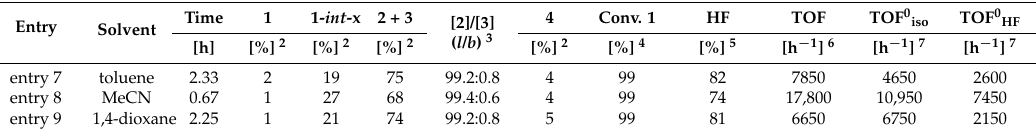
Figure 5. Influence of the solvent on the amount of internal isomers ( 1- int -x ) as a function of time in tandem isomerization-hydroformylation of 10-undecenitrile at [ 1 ] 0 /[Rh] = 3000 ( (cid:7) 1,4-dioxane, (cid:4) acetonitrile, (cid:78) toluene). Table 2. Influence of the solvent on tandem isomerization-hydroformylation of 10-undecenitrile at [ 1 ] 0 /[Rh] = 3000 1